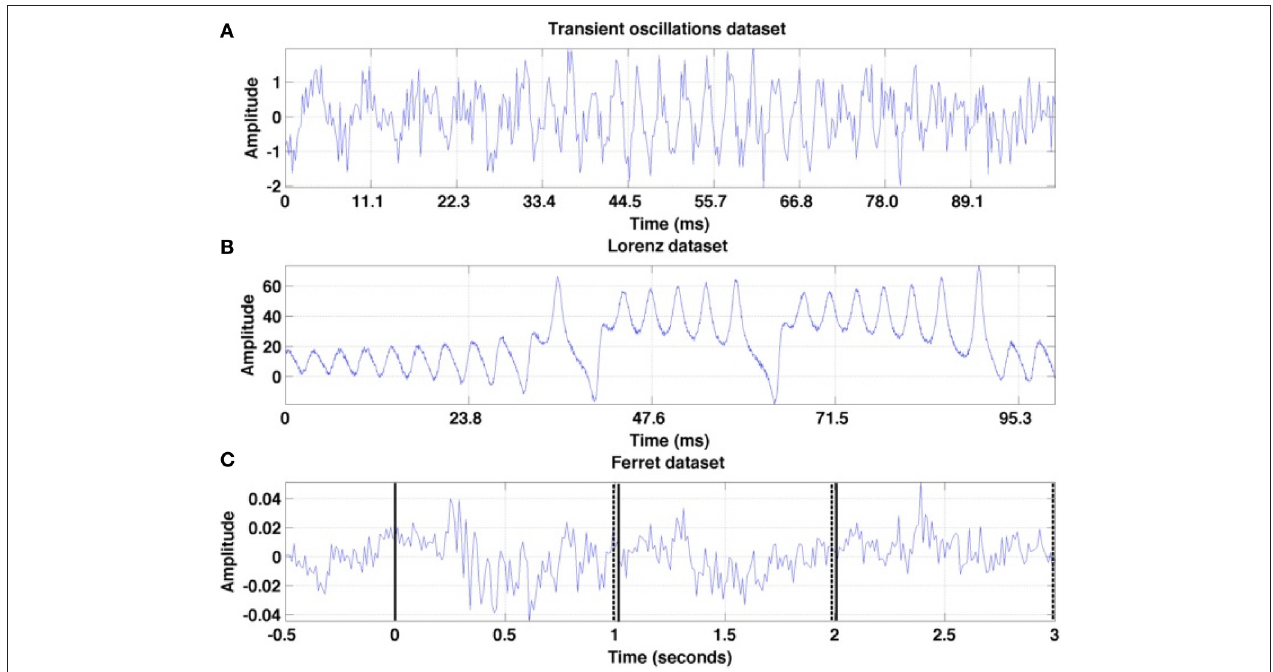
FIGURE 3 | Illustration of the first trial in each of the three time series under study. (A) Transient oscillations (B) Lorenz attractor (C) Ferret dataset: trial from the set session one is recorded at a granular layer electrode. The vertical solid lines denote the stimulus onsets and the set of dashed lines mark the stimulus offsets.